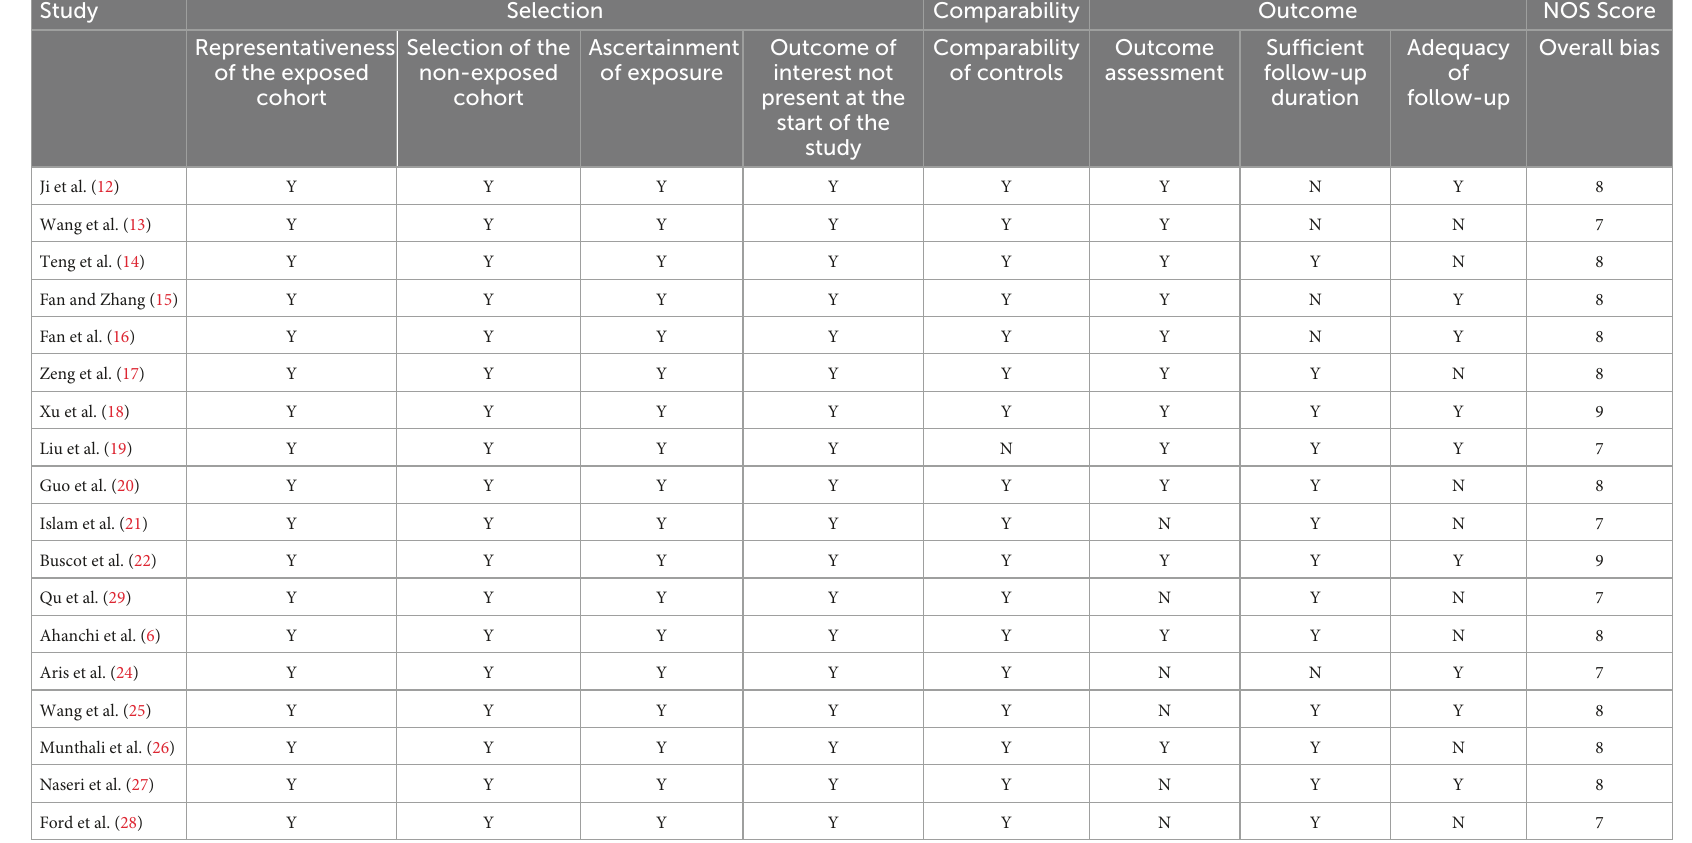
TABLE 6 Newcastle-Ottawa Score (NOS) calculation for studies included in the systematic